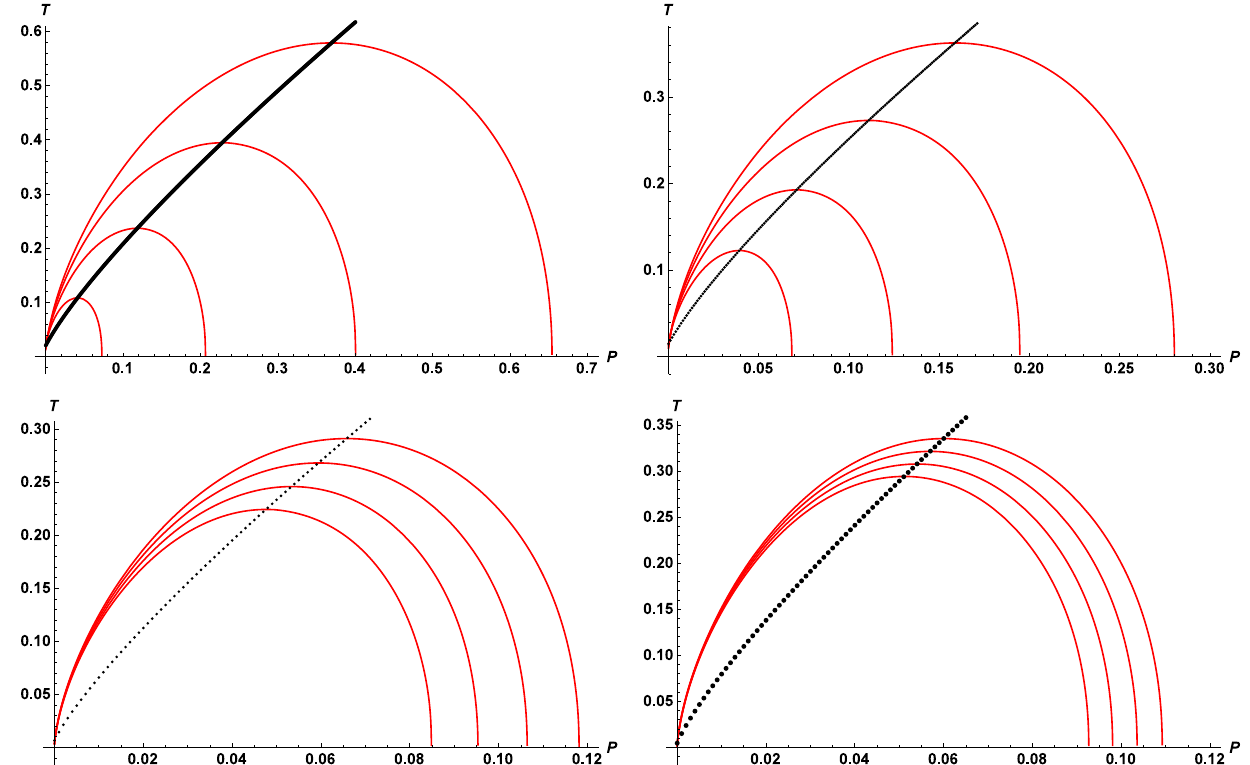
Fig. 2 Inversion and isenthalpic (constant mass) curves of Kerr–AdS black holes. Red and black lines present isenthalpic and inversion curves, respectively. From bottom to top, isenthalpic curves correspond to increasing values of M . (Top-left) J = 1 and M = 1 . 5 , 2 . 2 . 5 , 3.